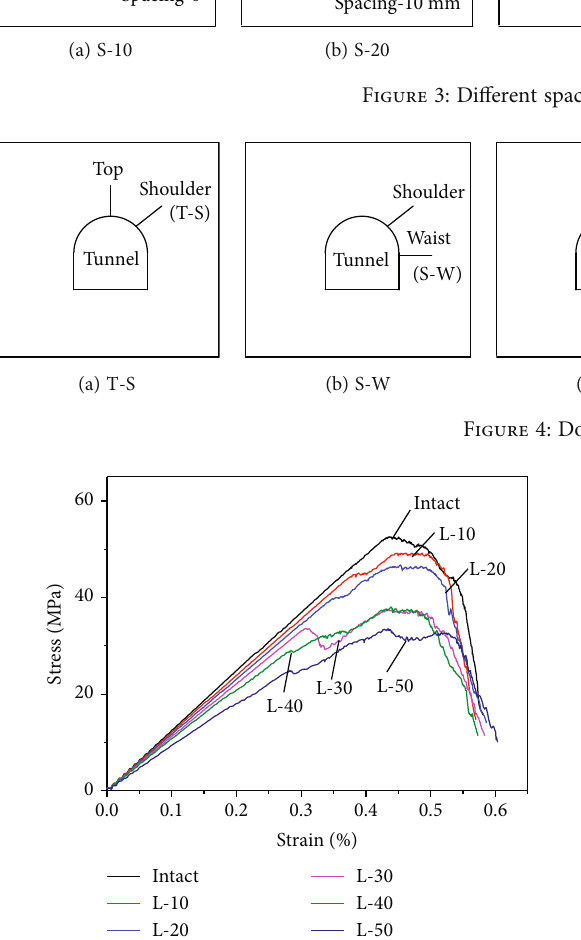
Figure 2: Di ff erent joint lengths.